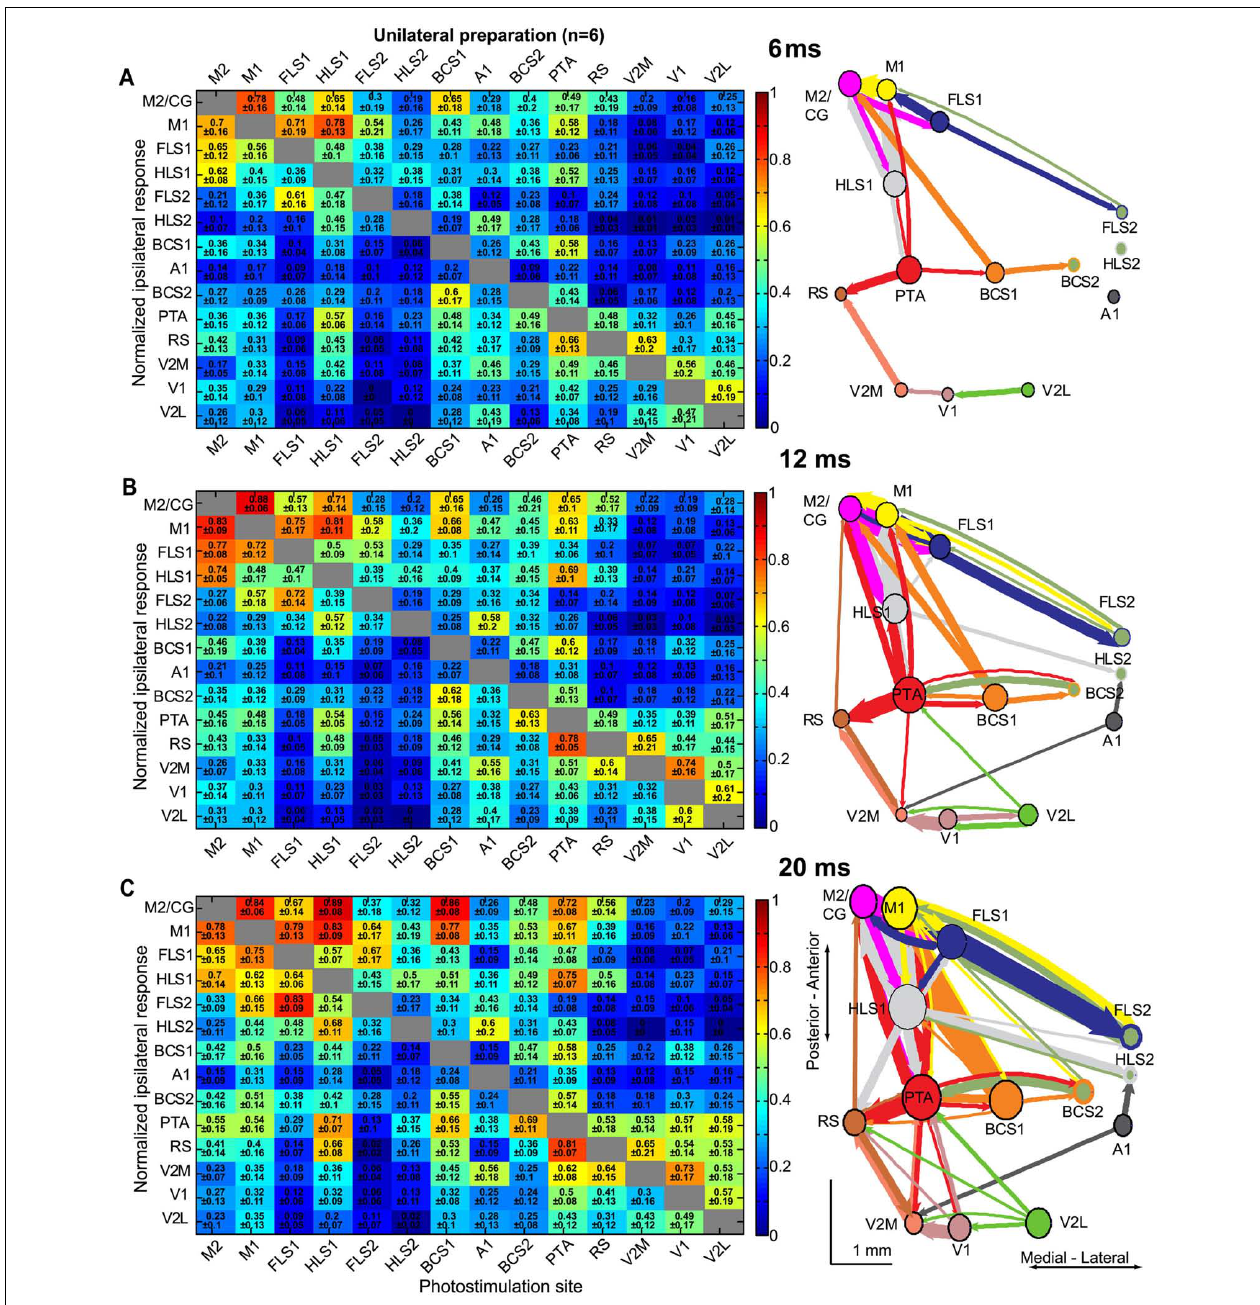
represent the sum of theVSD response from response onset. In each case, a 0.5 threshold was applied for display purposes so only the strongest connections were used to create the network diagrams. Nodes were placed according to the site of photostimulation.The size of node is proportional to the strength of connections per node (sum of weights) and arrow thickness between nodes is proportional to the weight of the